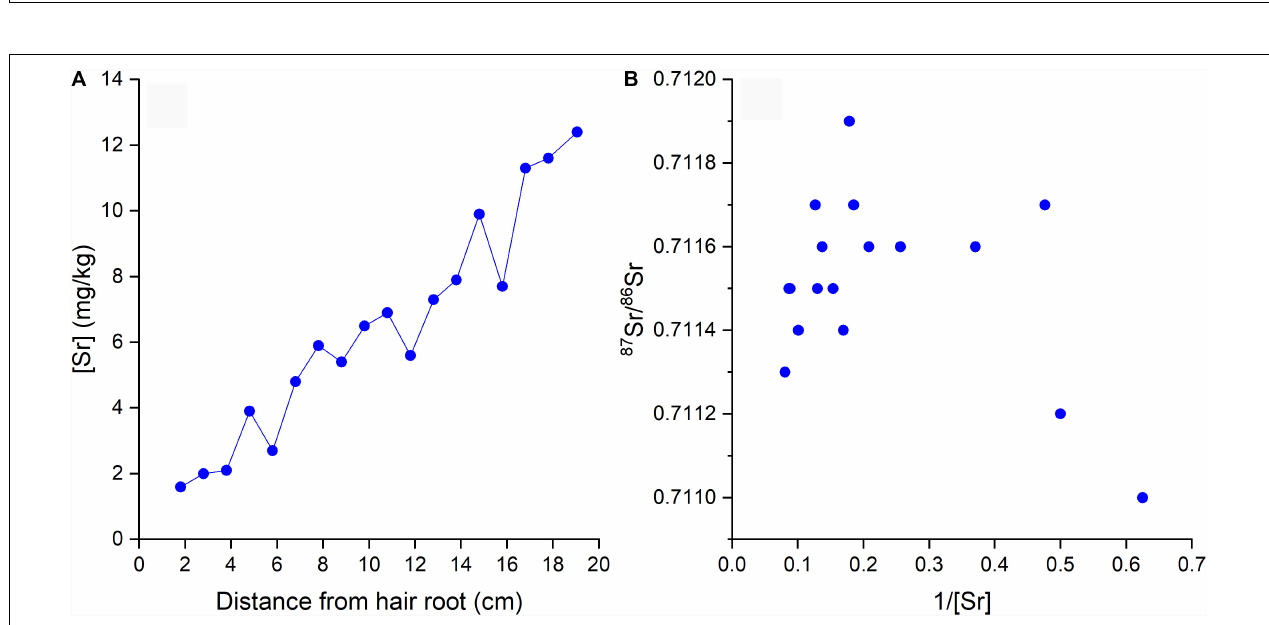
FIGURE 6 | (A) [Sr] in hair segments versus the distance from hair root; (B) 87 Sr/ 86 Sr versus 1/[Sr] in hair segments.